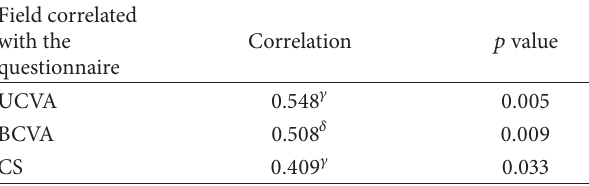
Table 5: Correlations. The table shows the correlation coefficients, all of which were statistically significant between the variations in questionnaire values and UCVA, BCVA, and CS values, which were 0.548, 0.508, and 0.409, respectively. This result demonstrates a direct and positive association between the items evaluated.